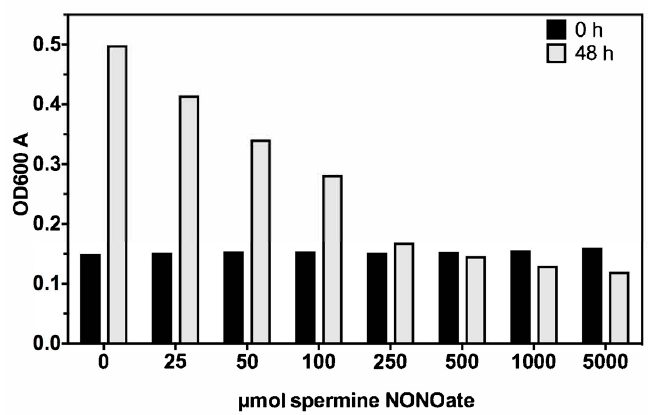
Figure 1. In vitro susceptibility of MAC104 to spermine NONOate. MAC104 was grown to OD600 of 0.15 in 7H9 broth supplemented with 10% oleic acid, albumin, dextrose and catalase (OADC) in a 37 ◦ C shaker. Spermine NONOate, a nitric oxide donor, was added at reported amounts and the cultures were incubated for an additional 48 h. The data is representative of three separate trials. Table 1. The list of the nitric oxide susceptible Mycobacterium avium subspecies hominissuis (MAH) mutants. MmT7 knockout clones were identified as those with 50% or less optical density when compared to the wild-type MAH after 48 hours of growth in 7H9 broth supplemented with 10% OADC and 100 µM spermine NONOate. MmT7 transposon insertion sites were identified by LM- PCR and Sanger sequencing. Gene ID Clone % of WT